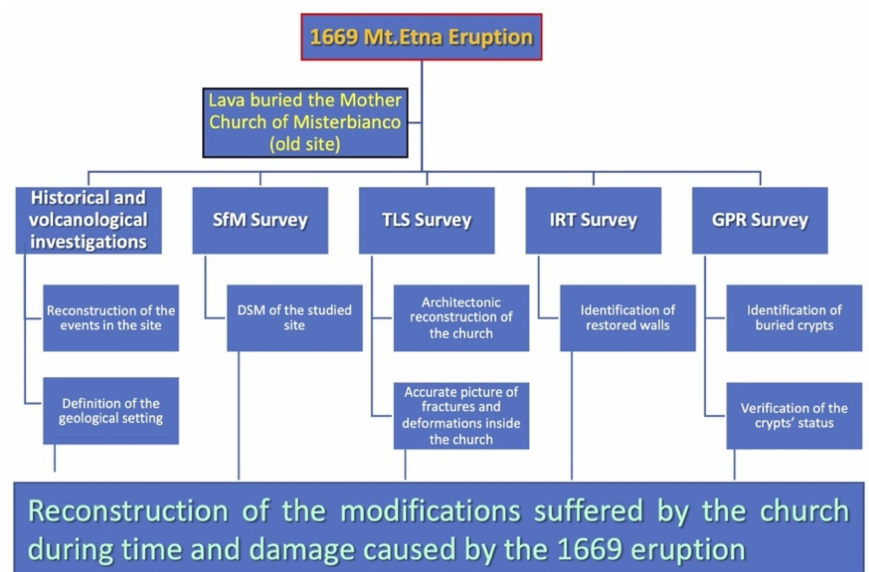
Figure 5. Diagram of multidisciplinary surveys applied in the old Misterbianco